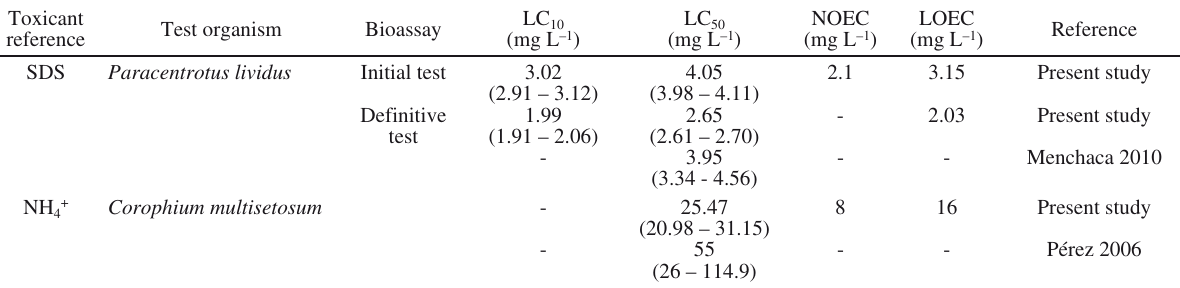
Table 3. – Lethal concentration (mg L –1 ) for SDS in Paracentrotus lividus and for NH 4+ in Corophium multisetosum , their respective confi- dence intervals (95%) and NOEC (mg L –1 ) and LOEC (mg L –1 ) values.